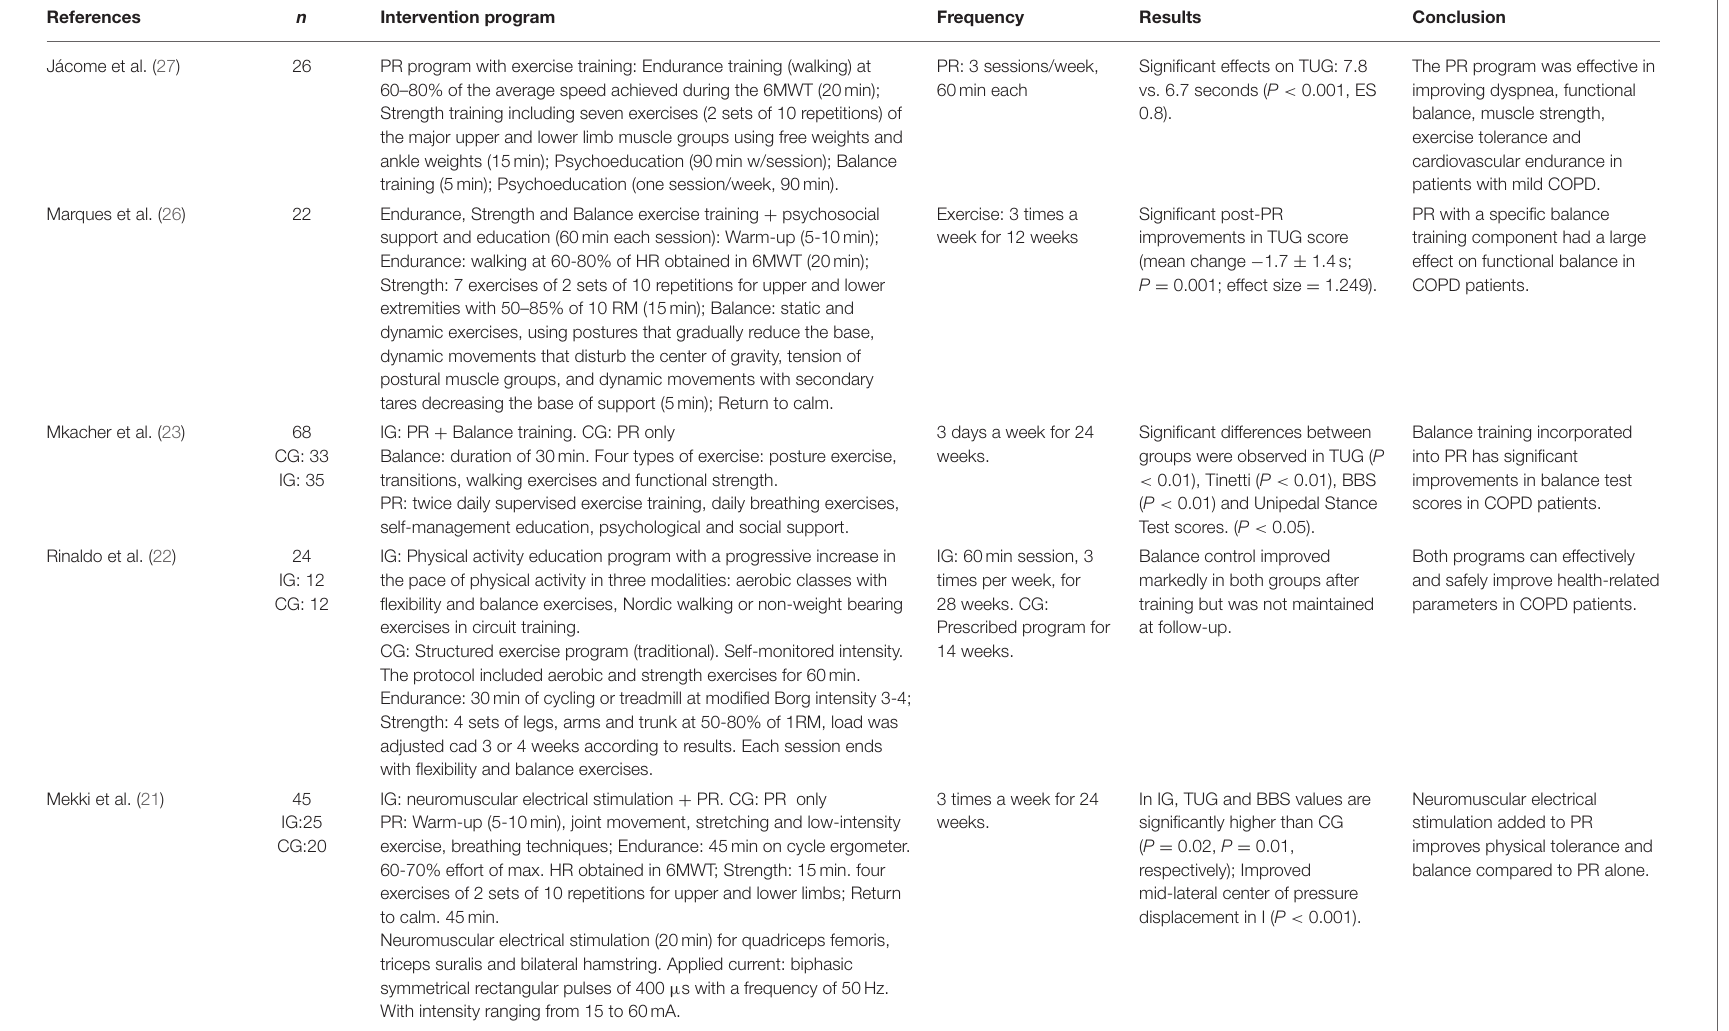
TABLE 2 | Synthesis of interventions and